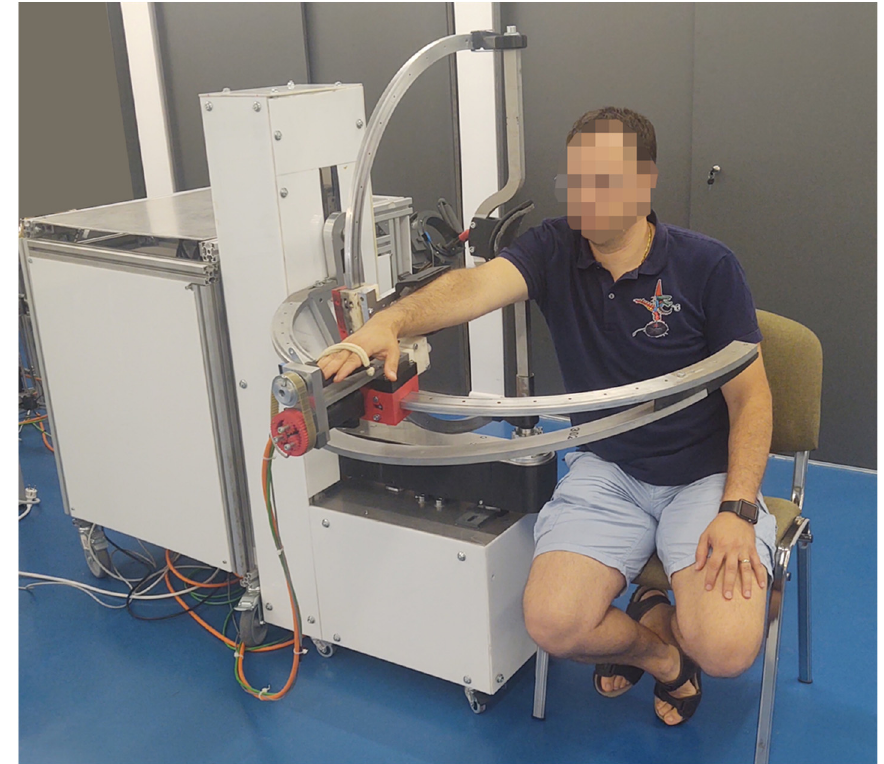
Figure 12. ASPIRE experimental model.